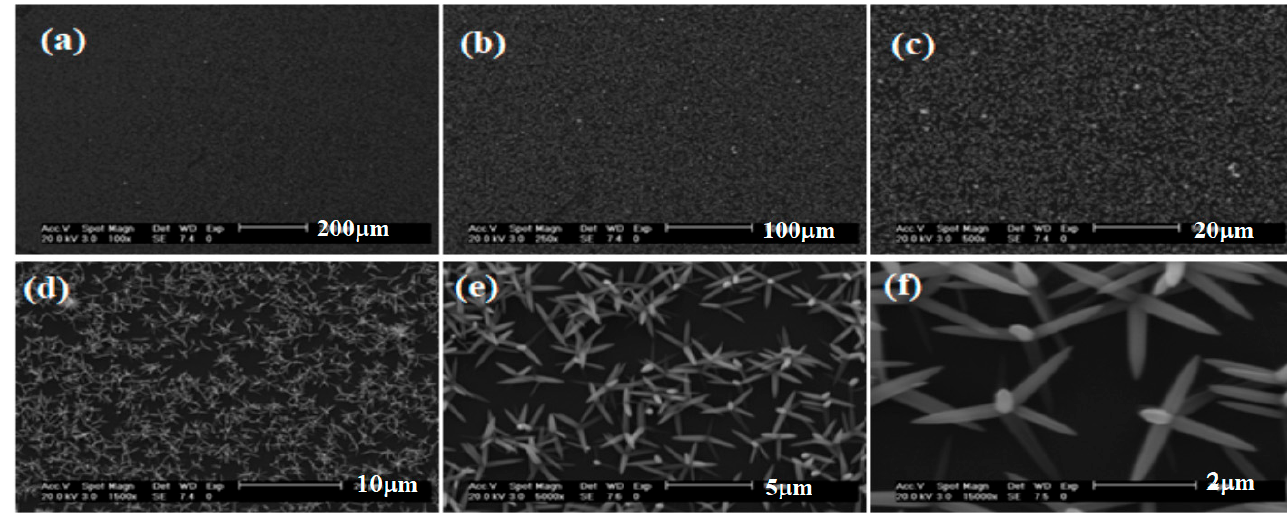
Figure 4. Typical FESEM images of the bunches (nano fl owers) of synthesized ZnO nanosheets at 85 °C for ZnO with pH 9 value at di ff erent scales: ( a ) 200 µm, ( b ) 100 µm, ( c ) 20 µm, ( d ) 10 µm, (e) 5 85 ◦ C for ZnO with pH 9 value at different scales: ( a ) 200 µ m, ( b ) 100 µ m, ( c ) 20 µ m, ( d ) 10 µ m, µm, ( f ) 2 µm. ( e ) 5 µ m, ( f ) 2 µ